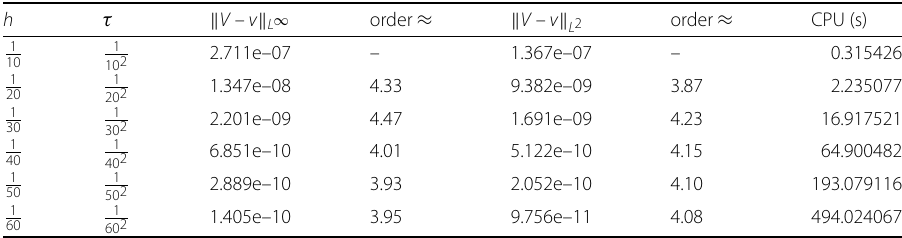
Table 8 Errors and computational orders of central difference scheme with β = 10 for V h